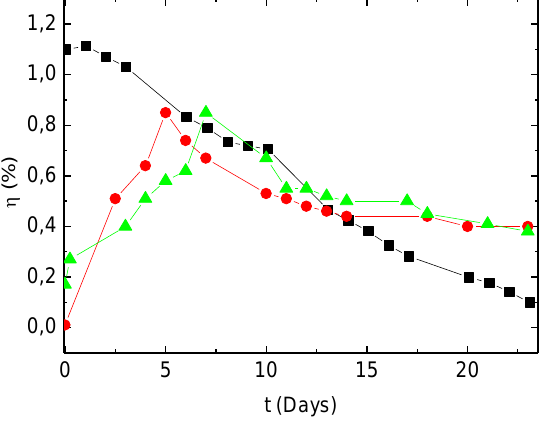
Figure 4. Variation with time of the efficiency of OPVCs with different CBLs: (■) CBL = Alq (9 nm); (●) CBL = Alq 3